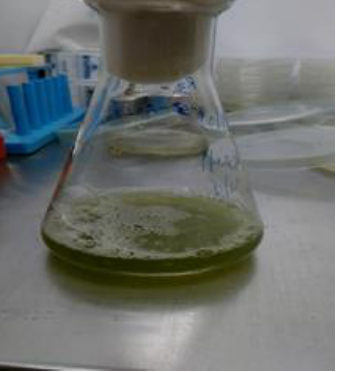
Figure 6. Pigment produced under submerged condition